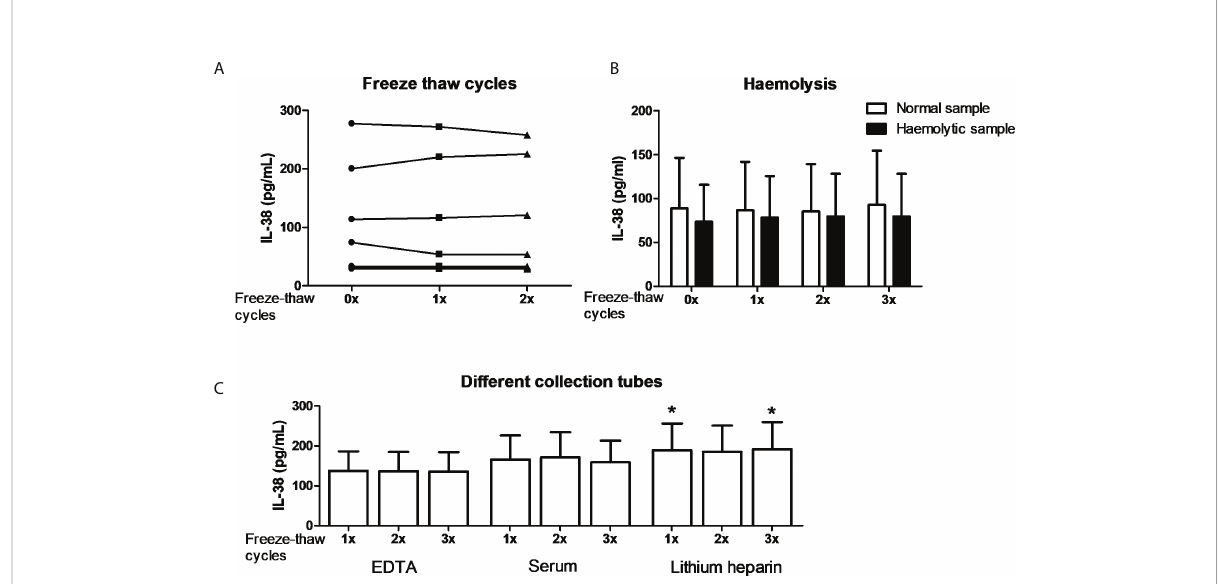
FIGURE 2 IL-38 concentrations and the effect of blood collection conditions. (A) IL-38 concentrations in EDTA serum were determined directly or after one or two freeze-thaw cycles between -80 degrees Celsius and room temperature. N=8. (B) Haemolytic plasma was compared to the corresponding non-haemolytic plasma, directly or after up to three freeze-thaw cycles. N=4. (C) Blood was collected in EDTA, serum, and heparin tubes and IL-38 concentrations were determined directly or after up to three freeze-thaw cycles. N=12, Wilcoxon matched-pairs signed rank test, *p<0,05 compared to the corresponding sample of both EDTA and serum